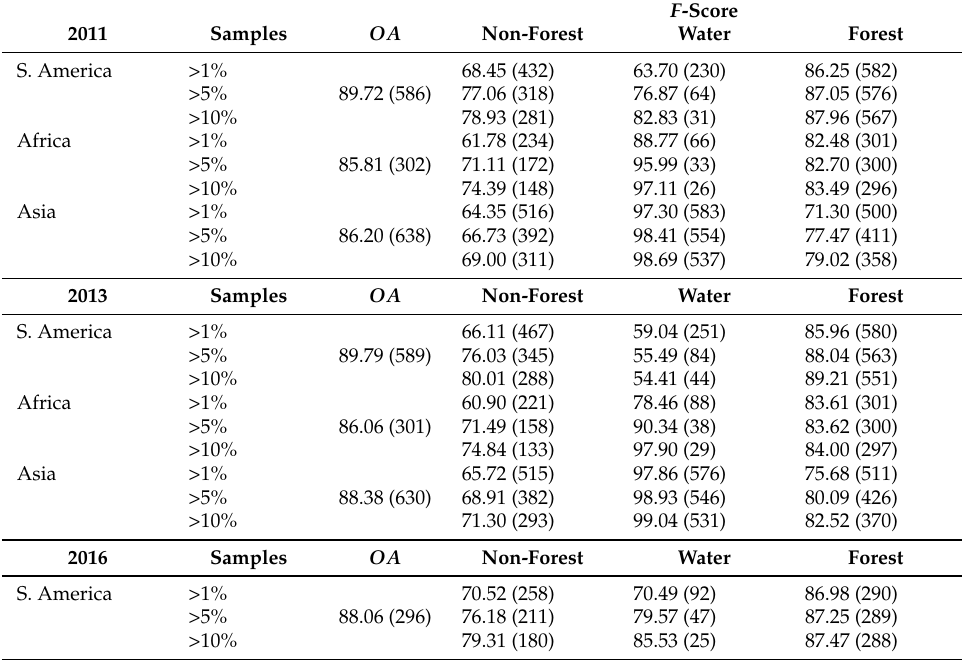
Table 2. Performance comparison between TanDEM-X mosaics and PALSAR. For an explanation of each field, please refer to the caption of Table 1.